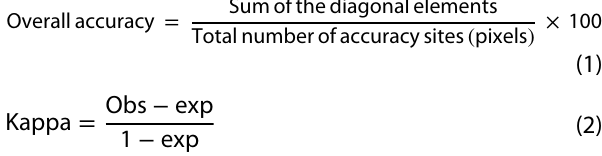
Table 1 Remote sensing data used in the study